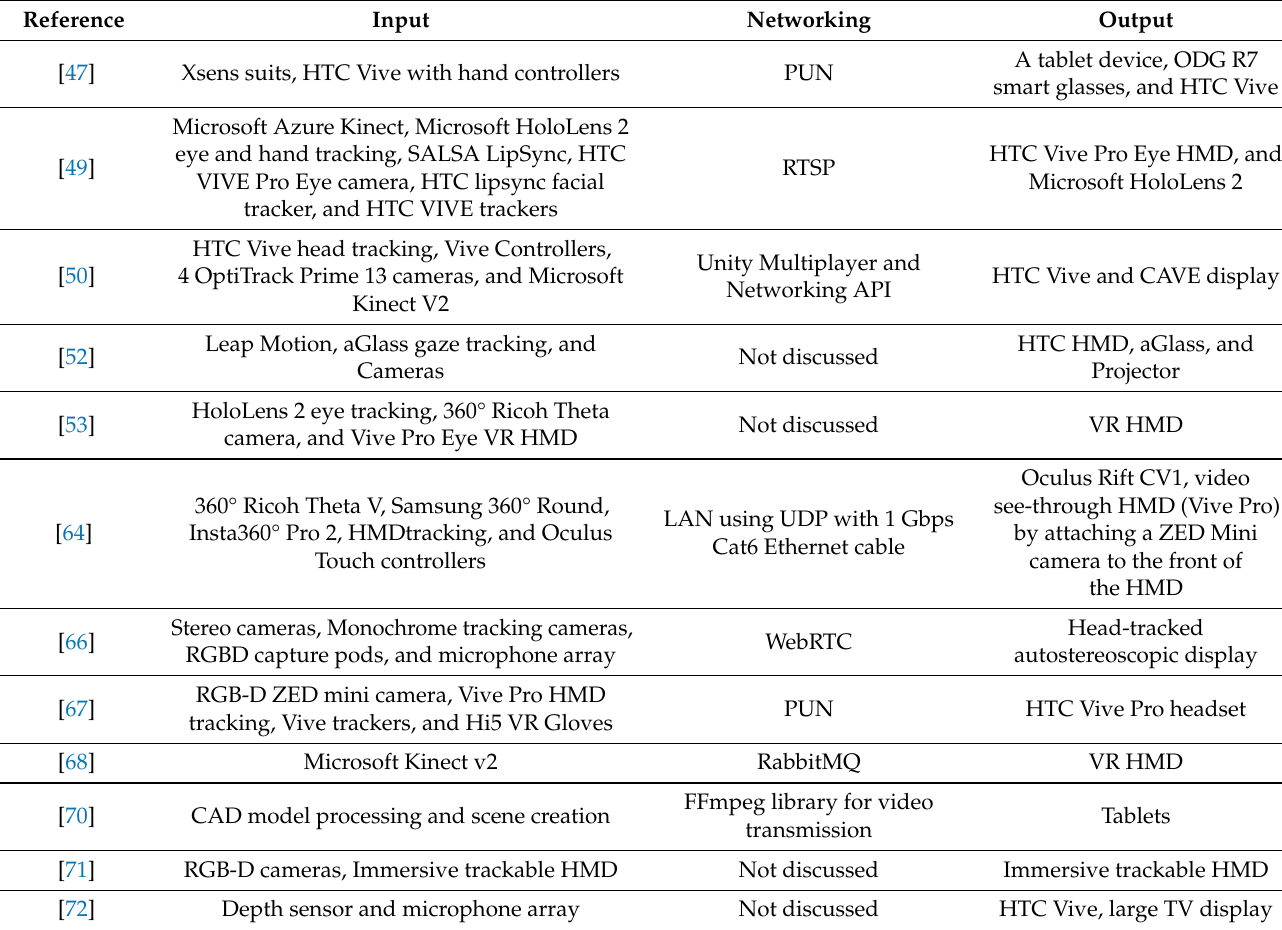
Table 6. HTC systems reviewed according to input and output technology, and